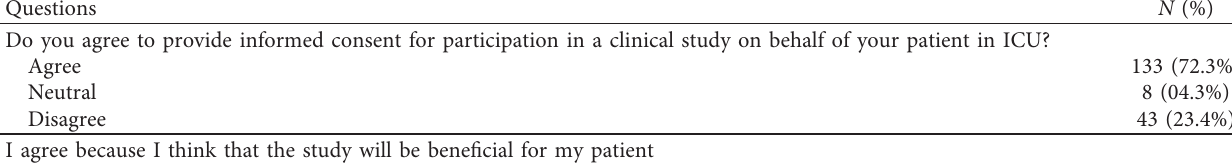
Table 2: Relatives’ attitudes toward informed consent for clinical research on behalf of the patients in ICU.